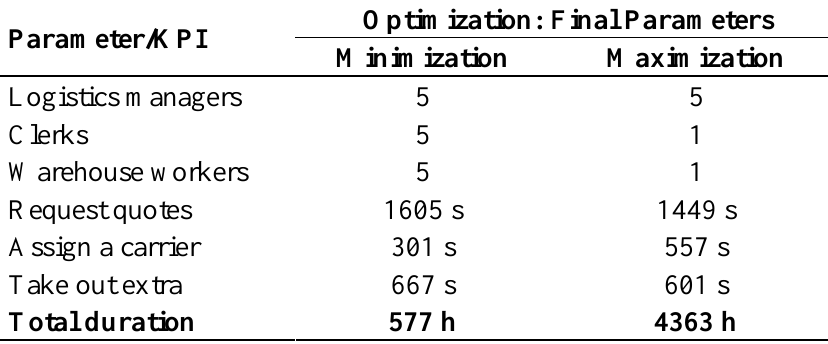
Table 8. Interval-valued results.